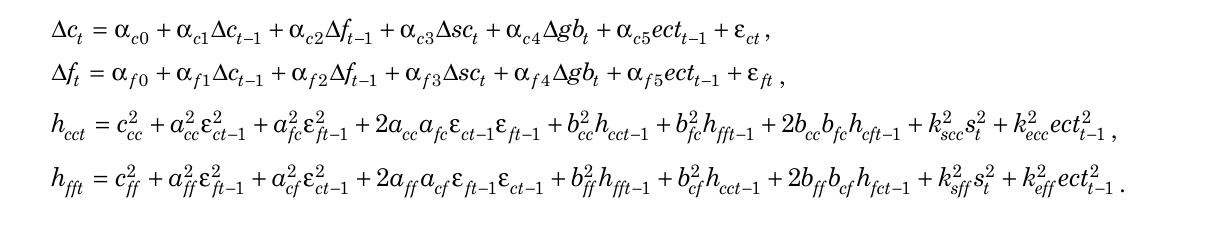
table 6. estimation of the ec-Var-BeKK-garcH-X model post-gfc this table presents the estimation results of the model below for the post-gfc